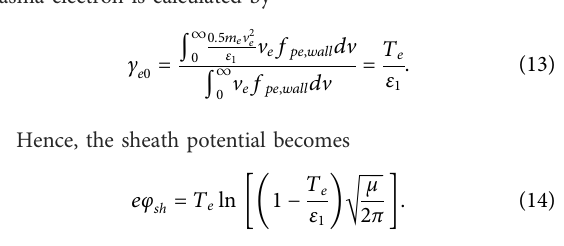
FIGURE 4 SEE coef fi cient as a function of incident electron energy. Normalization over ε max and γ max is applied. The subplot shows the comparison of γ e 0 with its linear approximation in the low- energy